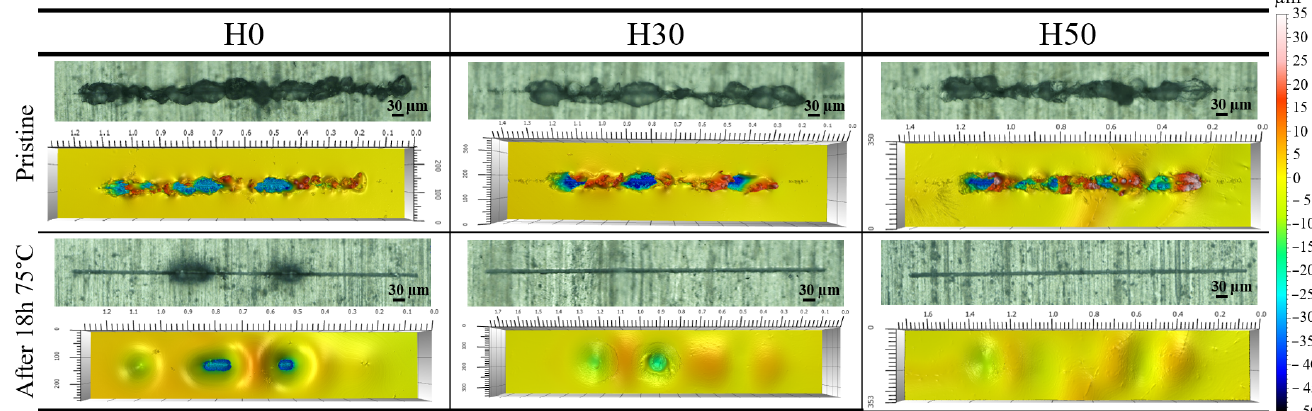
Figure 9. Optical and interferometric surface analysis results of indented coatings before and after 18 h at 75 °C.